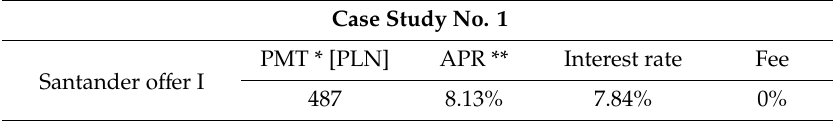
* PMT—amount of periodical (monthly) credit / loan repayment. Rate—interest rate per period of